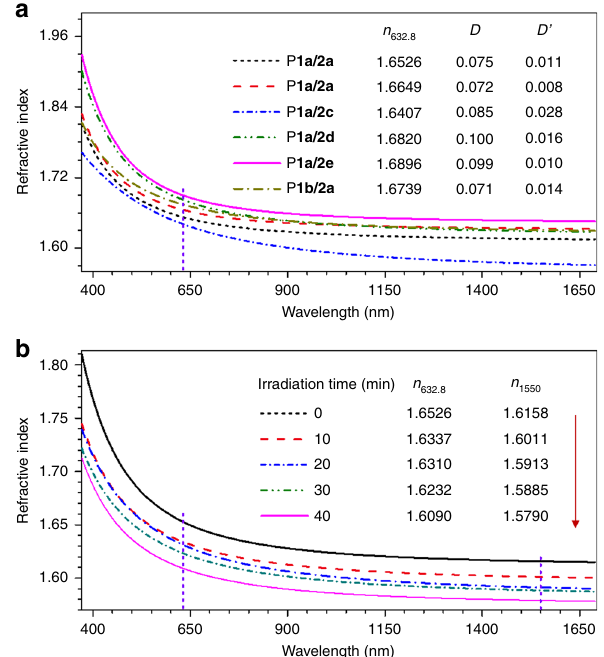
Fig. 5 Refractive index and chromatic dispersion of polymer thin fi lms. a Wavelength dependence of refractive indices of thin fi lms of P 1a – b / 2a – e . b Change in the refractive index of a thin fi lm of P 1a / 2a by UV irradiation for different durations. Abbreviation: n = refractive index; D = chromatic dispersion in the visible region = ( n F − n C )/( n D − 1), where n D , n F , and n C are the n values at wavelengths of Fraunhofer D, F, and C spectral lines of 589.2, 486.1, and 656.3 nm, respectively; D ’ = chromatic dispersion in the IR region = ( n 1064 − n 1550 )/( n 1319 − 1), where n 1064 , n 1319 , and n 1550 are the n values at 1064, 1319, and 1550 nm, respectively 57